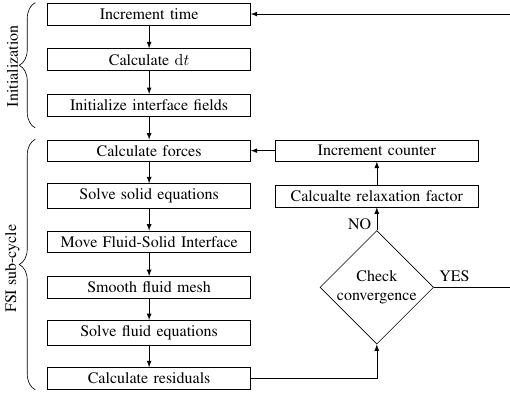
Figure 2. Flow chart of the FSI solution